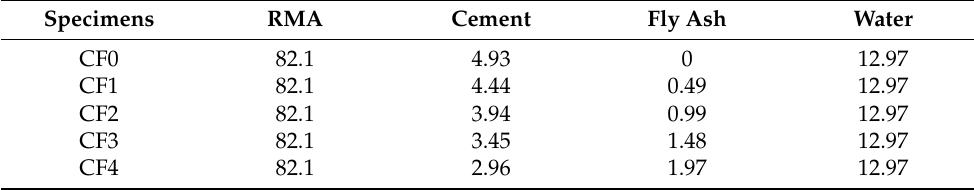
Table 2. The mixing ratio of CSM with 100% RMA under different fly ash replacement rates (wt